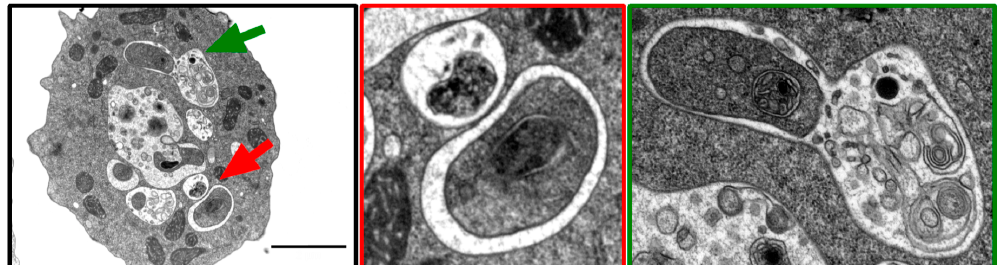
Figure 3. Visualization of autophagosomes in Dictyostelium by TEM. Electron micrographs of a Dictyostelium Ax2(Ka) cell treated with the autophagy inducer drug AR-12 at 2.5 µM for 2 h and with PI at 2.5× for 1 h. For imaging, cells were fixed for 1 h with 2% glutaraldehyde and stained for 30 min with a 2% osmium/0.1 M imidazole solution. Fixed cells were pelleted, washed in phosphate-buffered saline (PBS), and further processed, as previously described [38]. The red arrow marks the enlarged panel showing two autophagosomes; the green arrow marks the enlargement where a fusion event between a late endosome and an autophagosome can be observed. Scale bar, 2 µm.